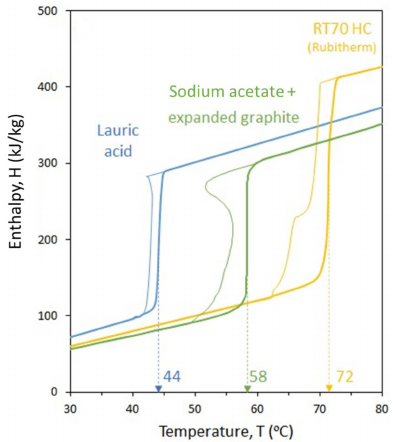
Figure 7. Characteristic temperature-dependant heat storage enthalpy of the three considered PCM for the simulation of the PCM-based heat storage tank as an alternative configuration of the SHIP solution adopted in the Spanish